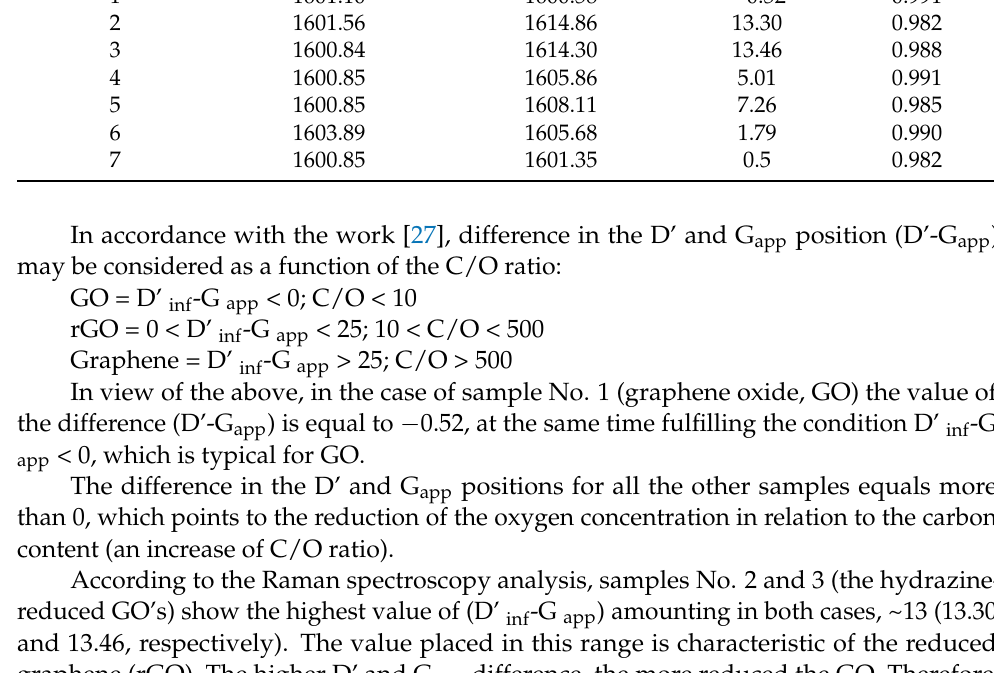
Table 2. Position of Raman spectra peaks for rGO. Sample